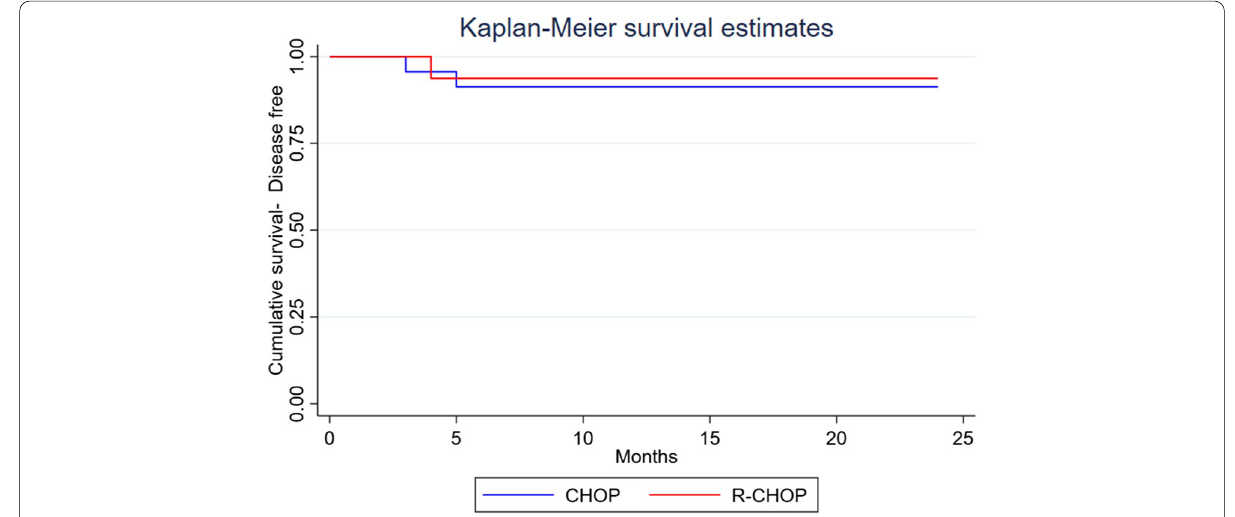
Fig. 2 Disease‑free survival by